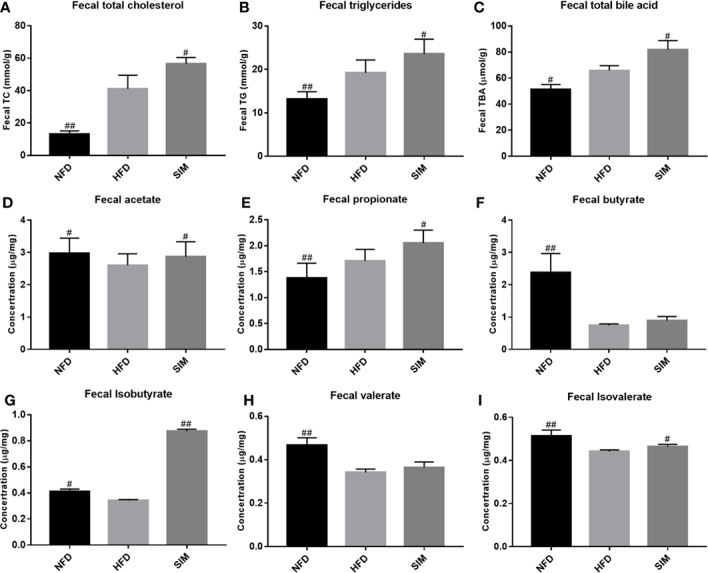
Effect of simvastatin administration on the fecal lipid levels and short-chain fatty acids (SCFAs) levels. (A) fecal TC, (B) fecal TG, (C) fecal TBA, (D) fecal acetate, (E) fecal propionate, (F) fecal butyrate, (G) fecal isobutyrate, (H) fecal valerate, and (I) fecal isovalerate levels. #P < 0.05 as compared to the HFD group, ##P < 0.01 as compared to the HFD group.